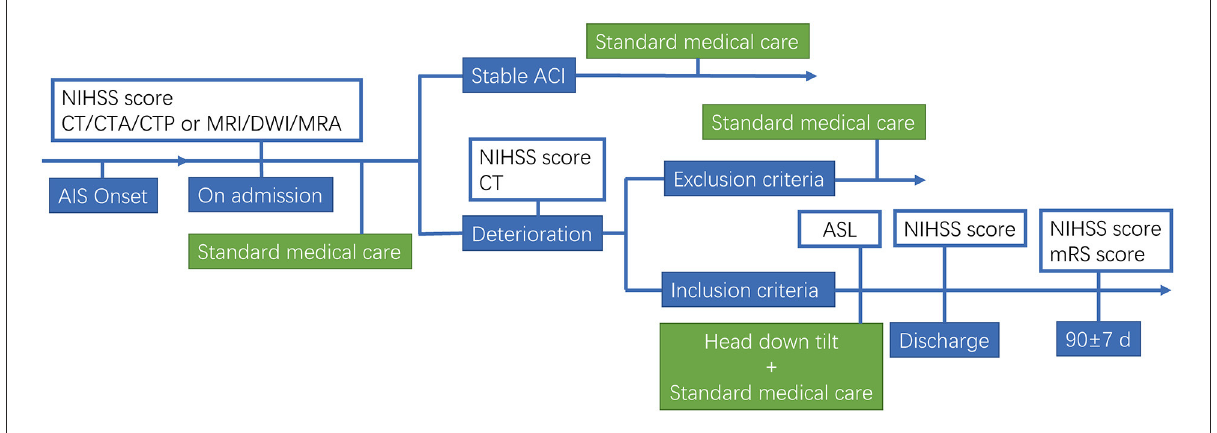
FIGURE1 Flow diagram of the